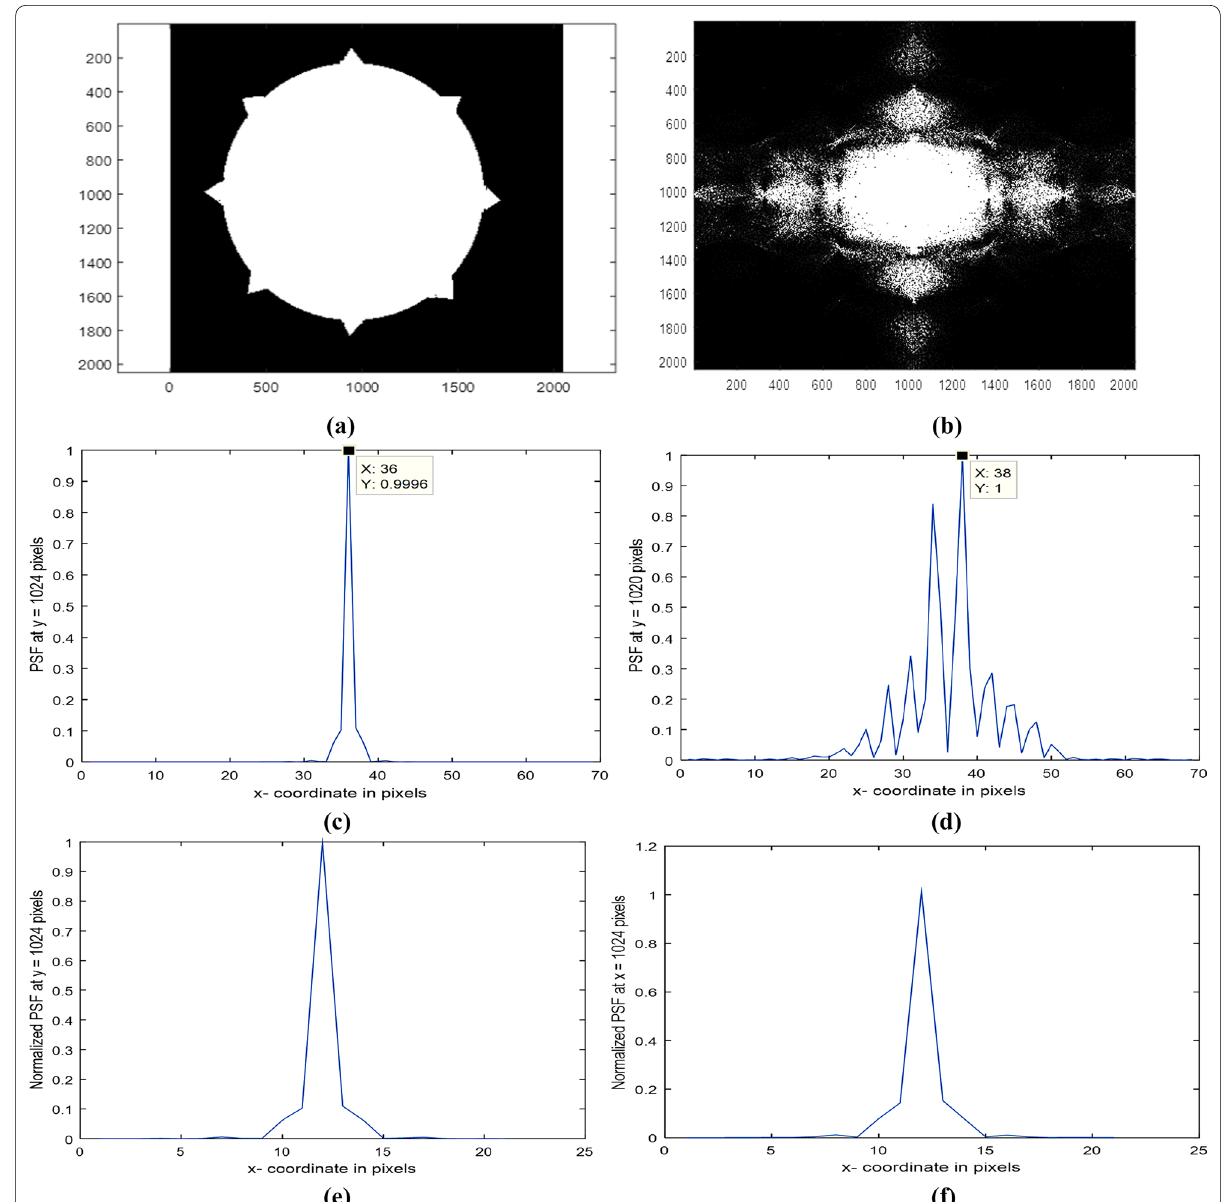
Fig. 3 a Uniform circular aperture with 8 spikes in a matrix of dimensions 2048 image corresponding to the aperture is shown in ( a ). c : The Normalized PSF plot in the range from 990 up to 1058 pixels corresponding to the image is shown in the a . d : The Normalized PSF plot in the range from 990 up to 1058 pixels at y shown in a . e : The Normalized PSF plot in the range from 1014 up to 1034 pixels at y Normalized PSF plot in the range from 1014 up to 1034 pixels at x